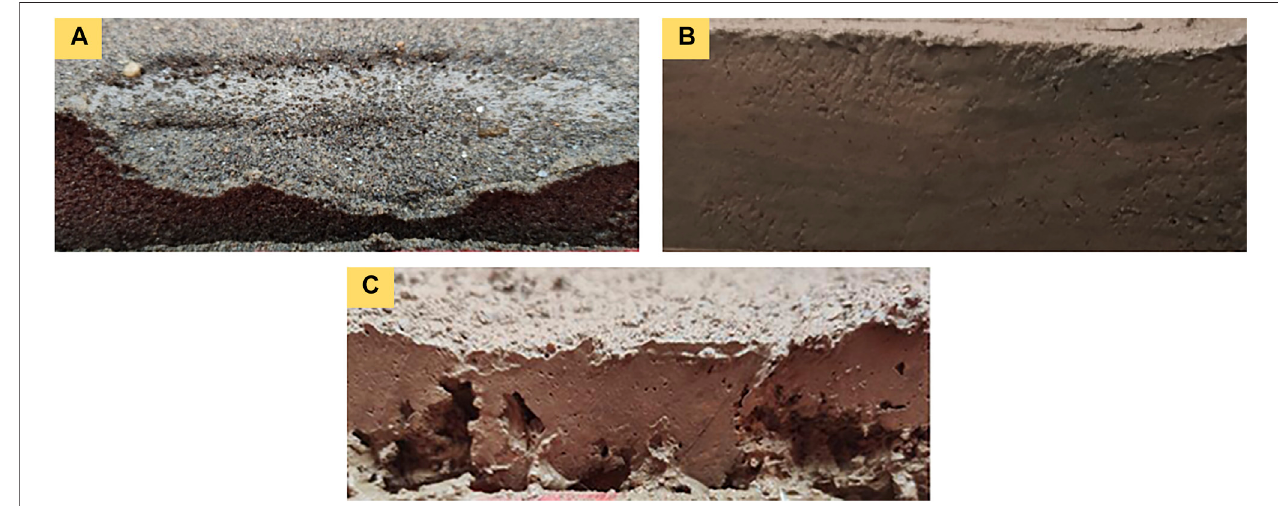
FIGURE 6 | Pro fi le phenomena after the erosion of three types of soils. (A) Silt; (B) silty clay; and (C) loess.